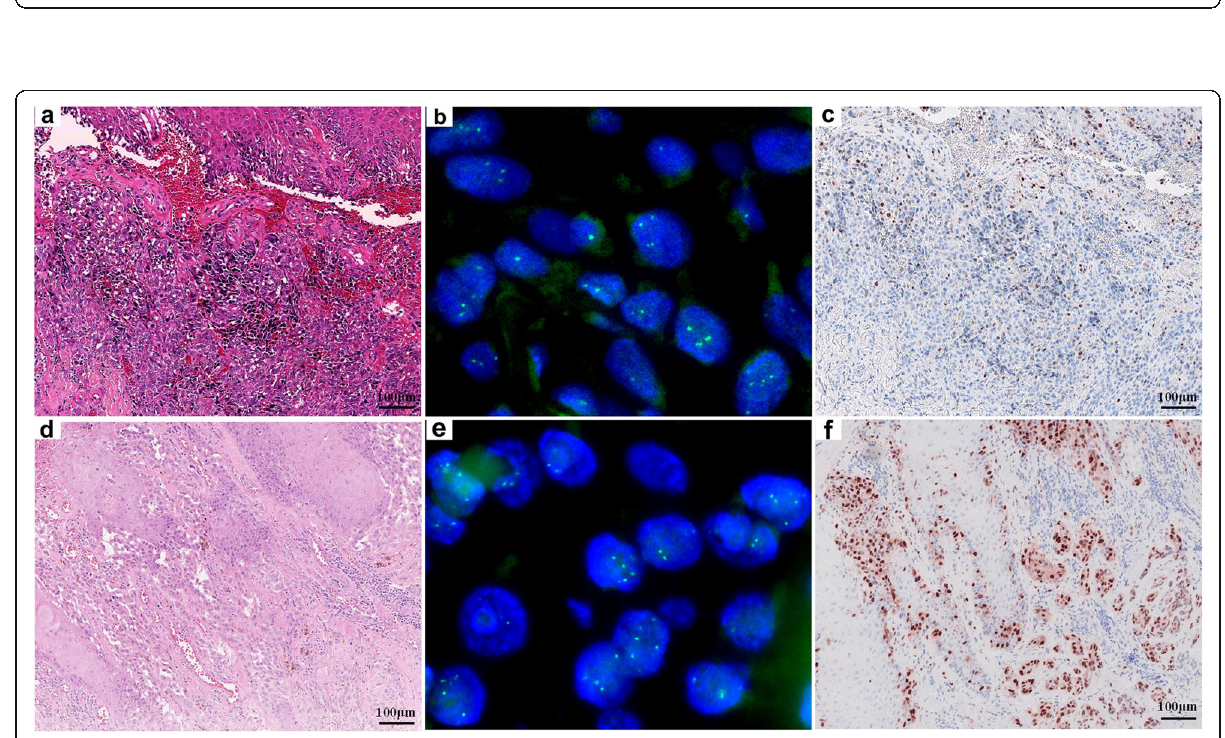
Fig. 2 Acral melanomas with normal CCND1 copy number may show either low- or high-expression of cyclin D1 protein. An acral melanoma on the thumb of a 57-year-old male with normal CCND1 copy number shows low expression of cyclin D1 protein ( a , HE 100x; b , CCND1 copy number by FISH; c , cyclin D1 expression by IHC). An acral melanoma on the hand of an 80-year-old female with normal CCND1 gene copy number shows high expression of cyclin D1 protein ( d , HE 100x; e , CCND1 copy number by FISH; f, cyclin D1 expression by IHC)